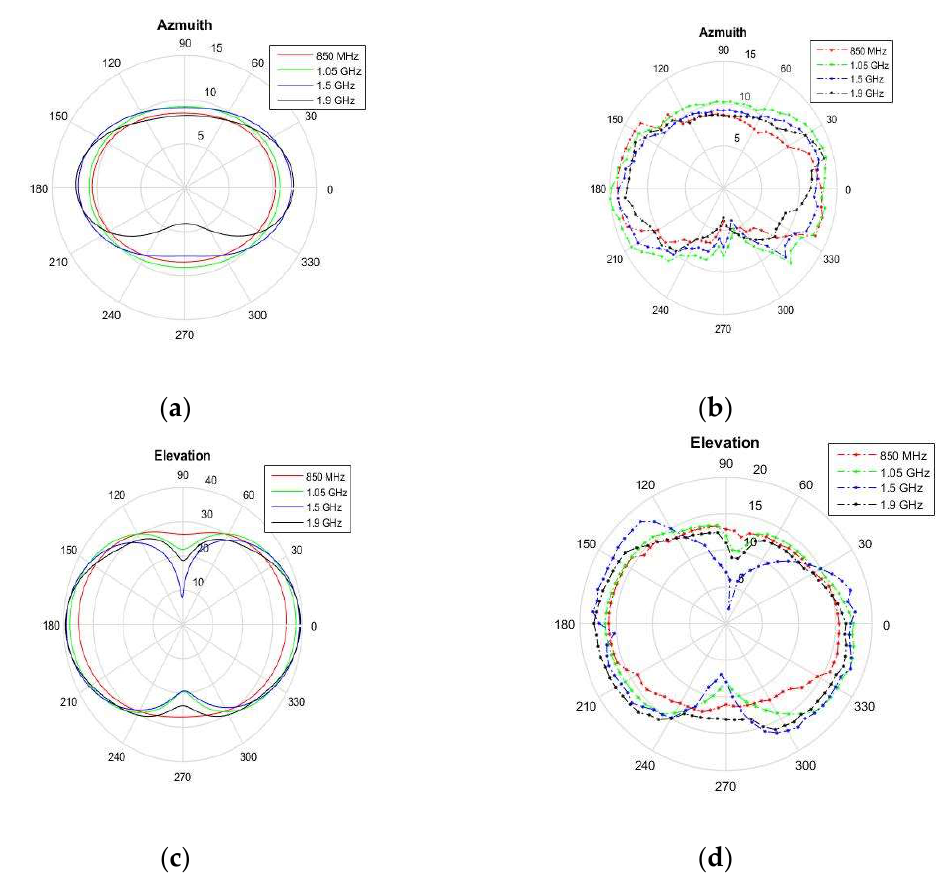
Figure 17. Simulated and measured radiation pattern: ( a ) simulated azimuth, ( b ) measured azimuth, ( c ) simulated elevation, ( d ) measured elevation.